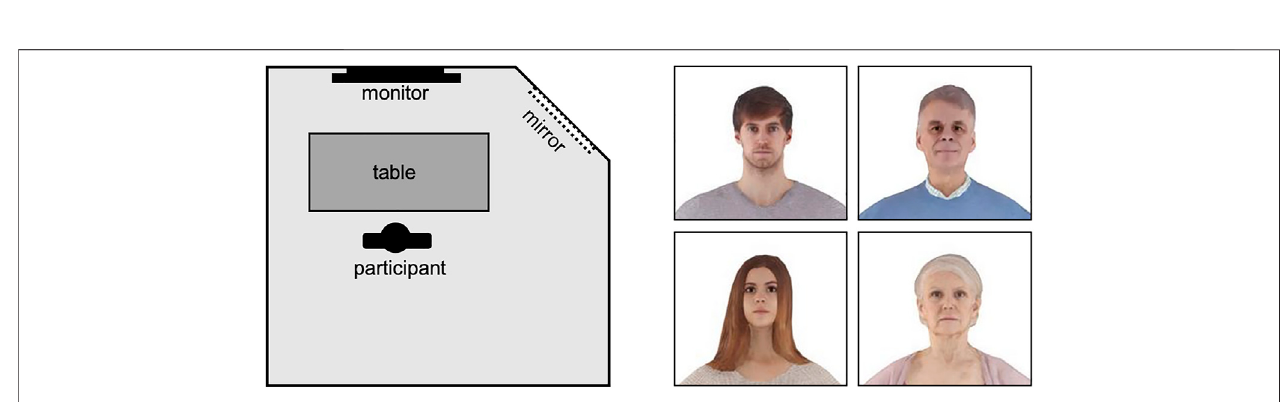
FIGURE 2 | Layout of VR laboratory (not to scale) and avatar